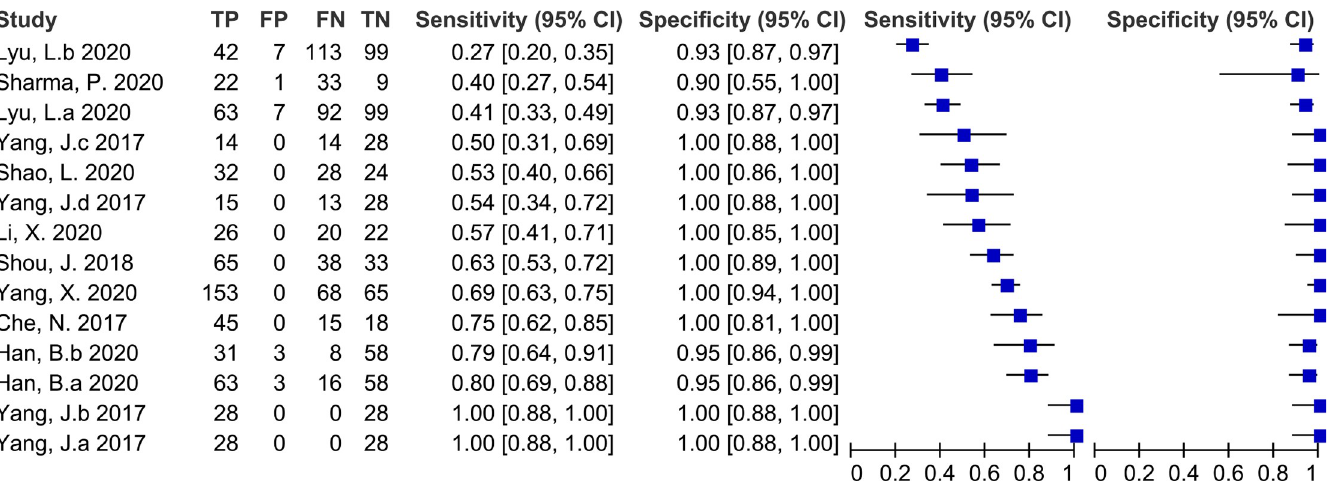
Fig 3. Forest plot for the sensitivity and specificity of cell free DNA for the diagnosis of tuberculosis compared with a composite reference standard.